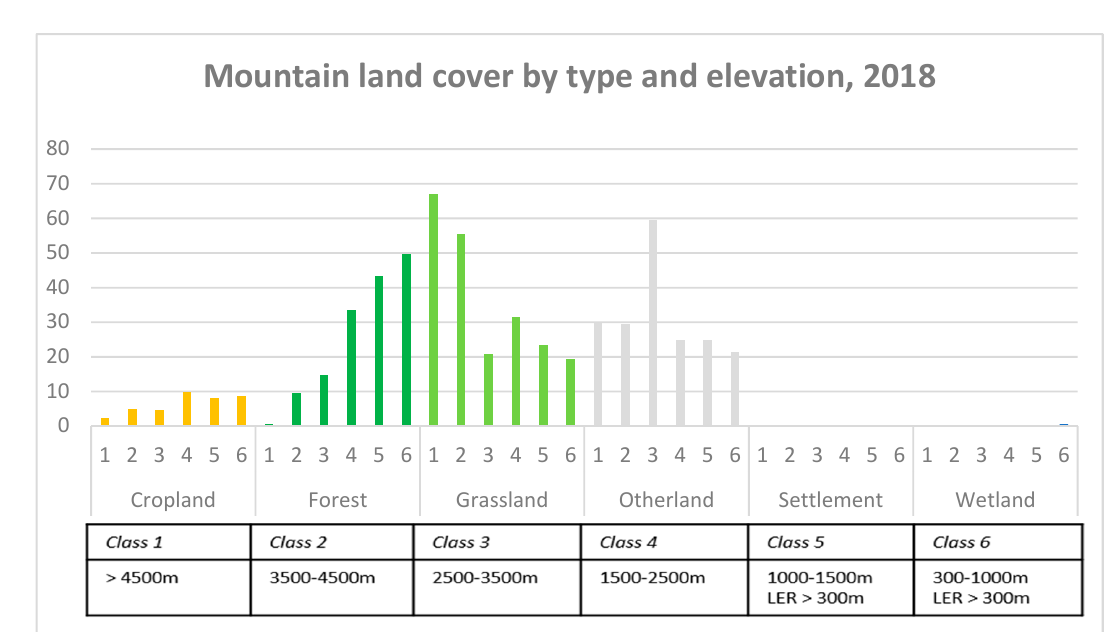
Figure 4. Distribution of land cover types by elevation class in 2018.